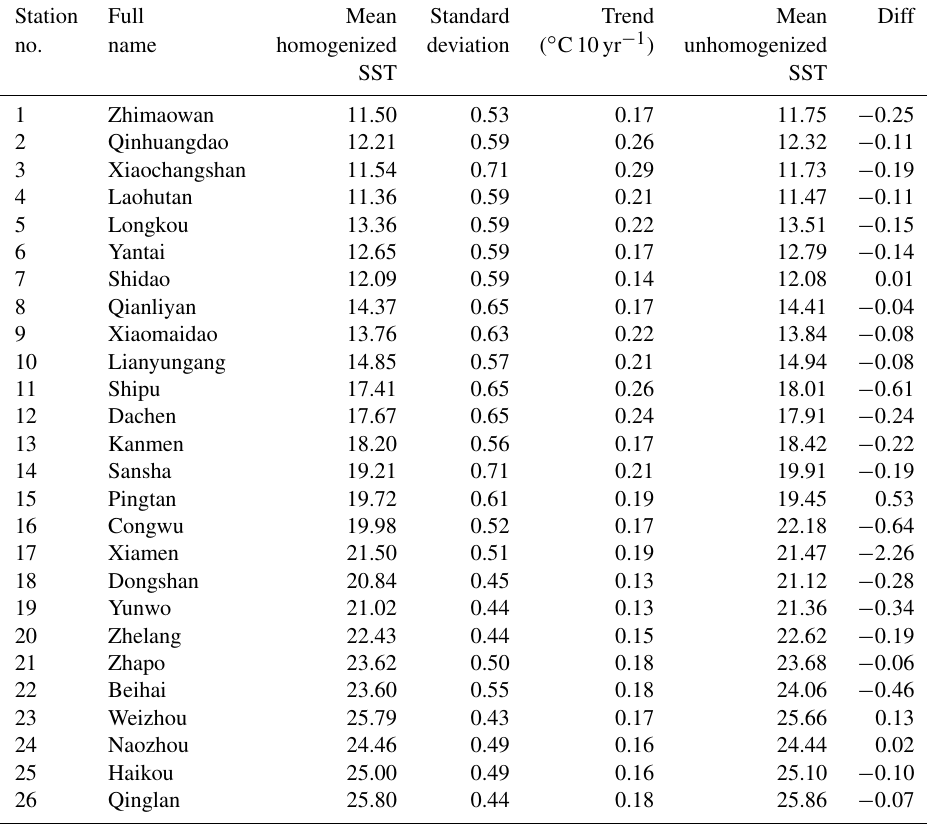
Table 2. Statistics of the time series of the annual homogenized local SST, plus the differences from the raw data, which were used to construct the homogenized series (columns 6 and